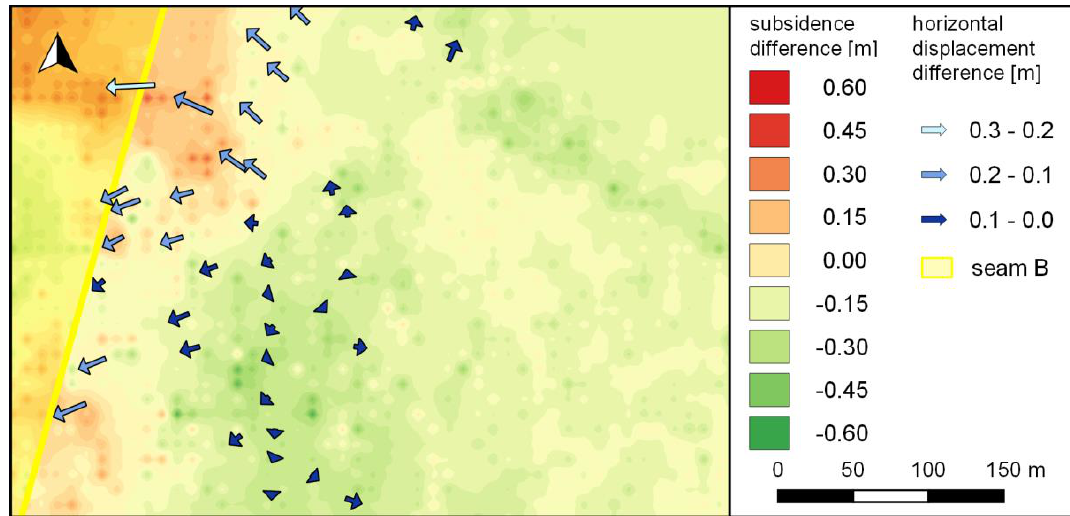
Figure 14. Di ff erences between forecasted and observed subsidences (color map) and horizontal Figure 14. Differences between forecasted and observed subsidences (color map) and horizontal displacements (di ff erential displacements (differential vectors).